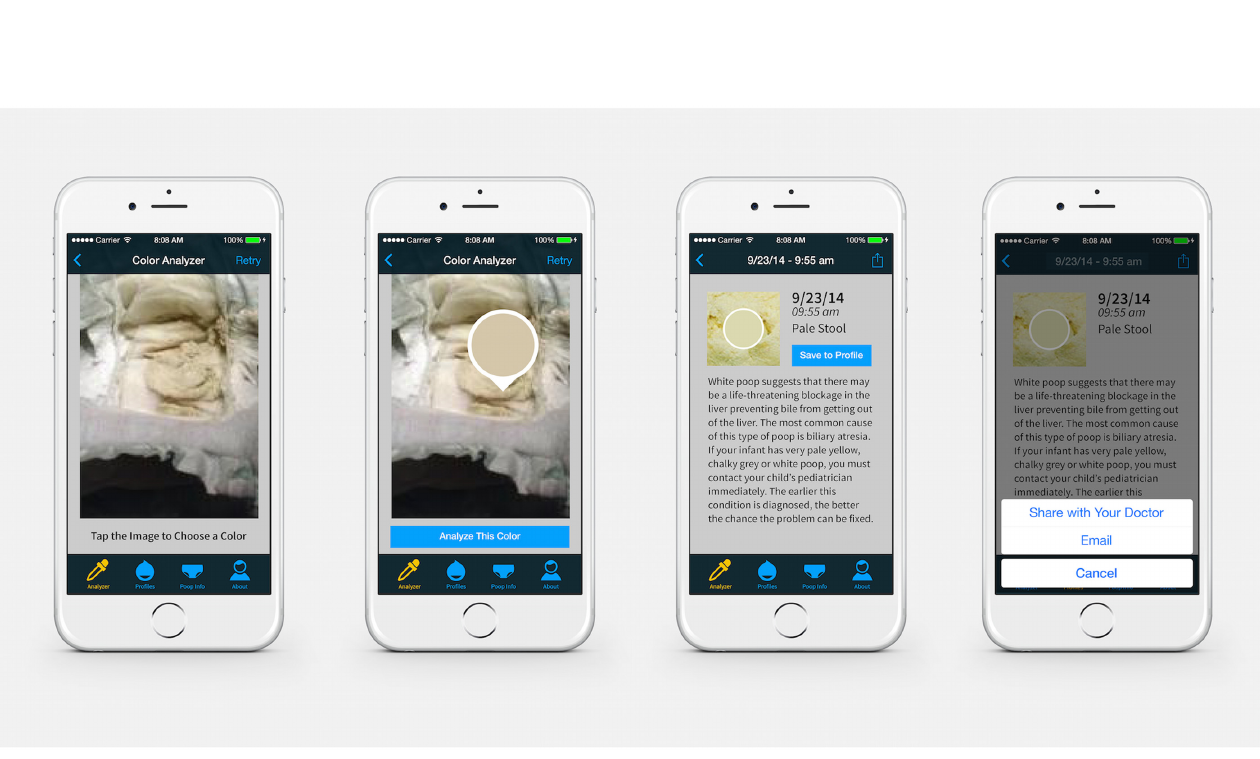
PLOS ONE | DOI:10.1371/journal.pone.0132270 July 29,